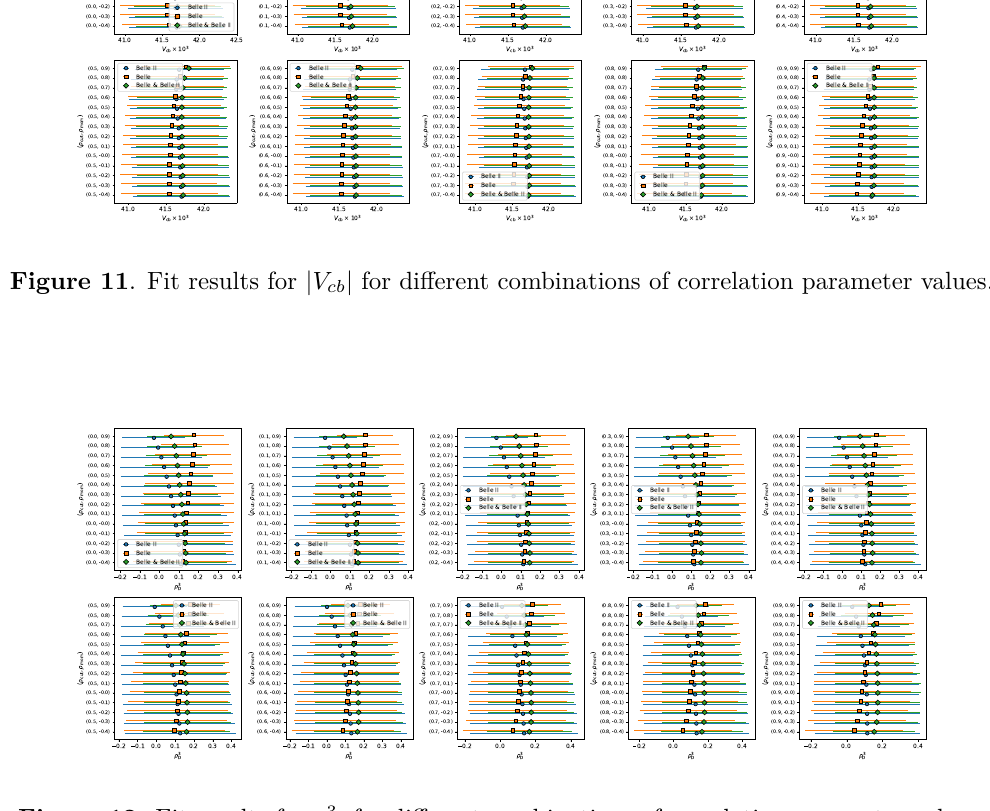
for different combinations of correlation parameter values. Figure 12 . Fit results for ρ 3 D